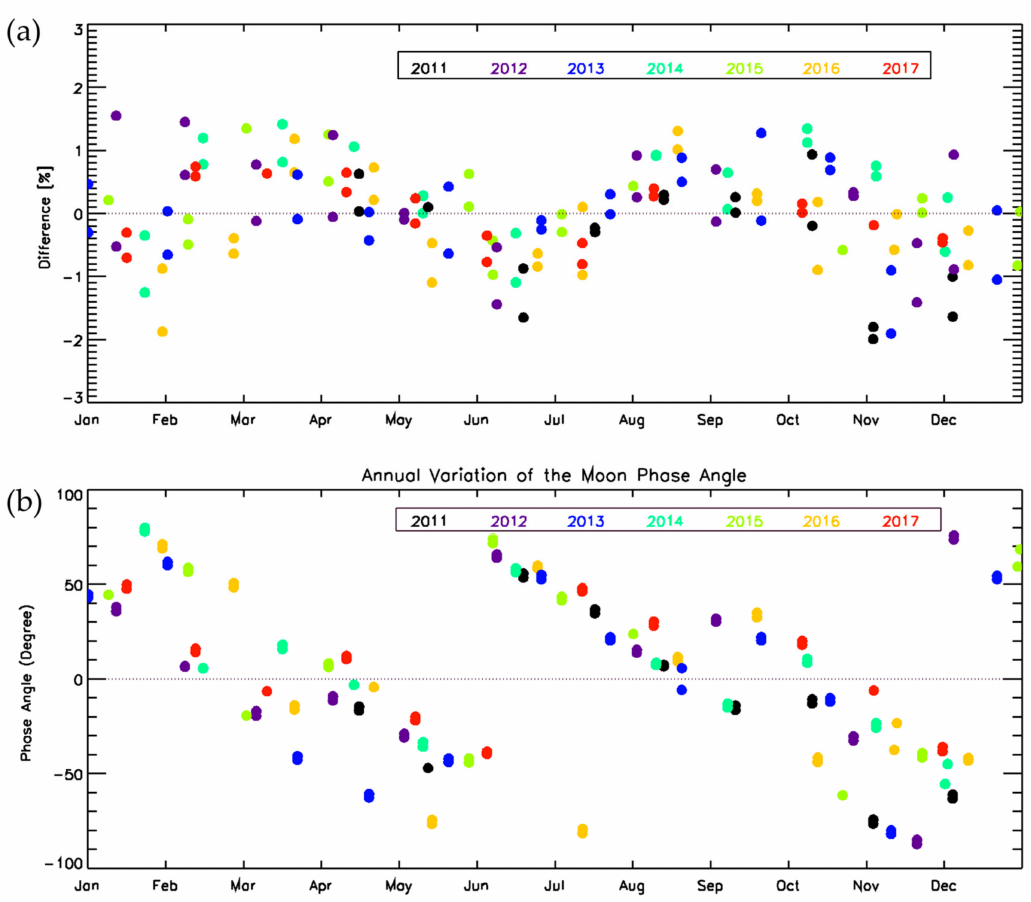
Figure 3. ( a ) Difference between degradation ratio and regression value (R(I Instrument /I ROLO ) − R (cid:48) [y = mx + b] (%)). The annual difference between degradation ratio and regression value is evident and shows a clear seasonal variation. ( b ) Variations in phase angle annually from April 2011 to December 2017 (the year is divided into two parts: January to June and July to